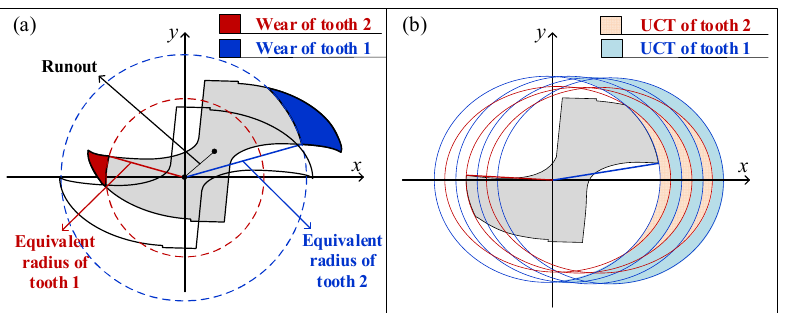
Figure 1. Equivalent cutting radius and uncut chip thickness. ( a ) Equivalent cutting radius under tool runout and tool wear. ( b ) Uncut chip thickness with the equivalent cutting radius.